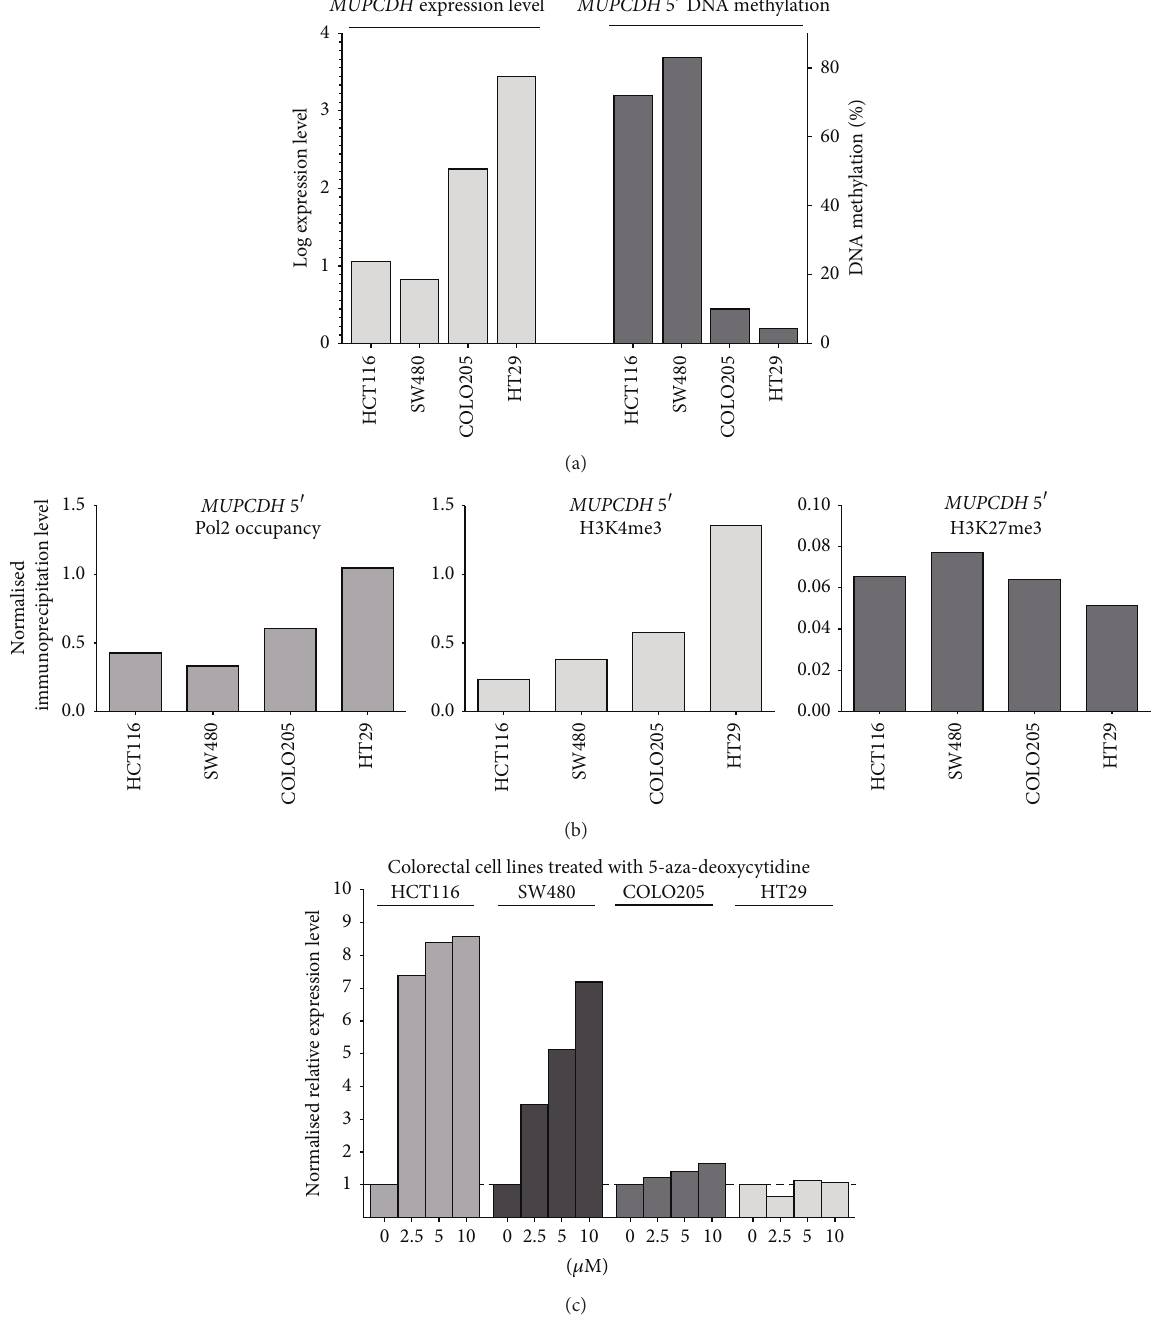
Figure 4: The role of MUPCDH 5 󸀠 DNA methylation for gene expression in colorectal cancer cell lines. (a) Comparison of MUPCDH expression and DNA methylation levels in four cell lines: HCT116, SW480, COLO205, and HT29; (b) results of the chromatin immunoprecipitation assay showing the level of RNA polymerase II binding as well as the levels of H3K4me3 and H3K27me3 at the MUPCDH promoter in four cell lines with diverse gene expression; (c) MUPCDH expression levels in colorectal cell lines cultured with various concentrations of DNA methyltransferase inhibitor, 5-aza-2 󸀠 -deoxycytidine.